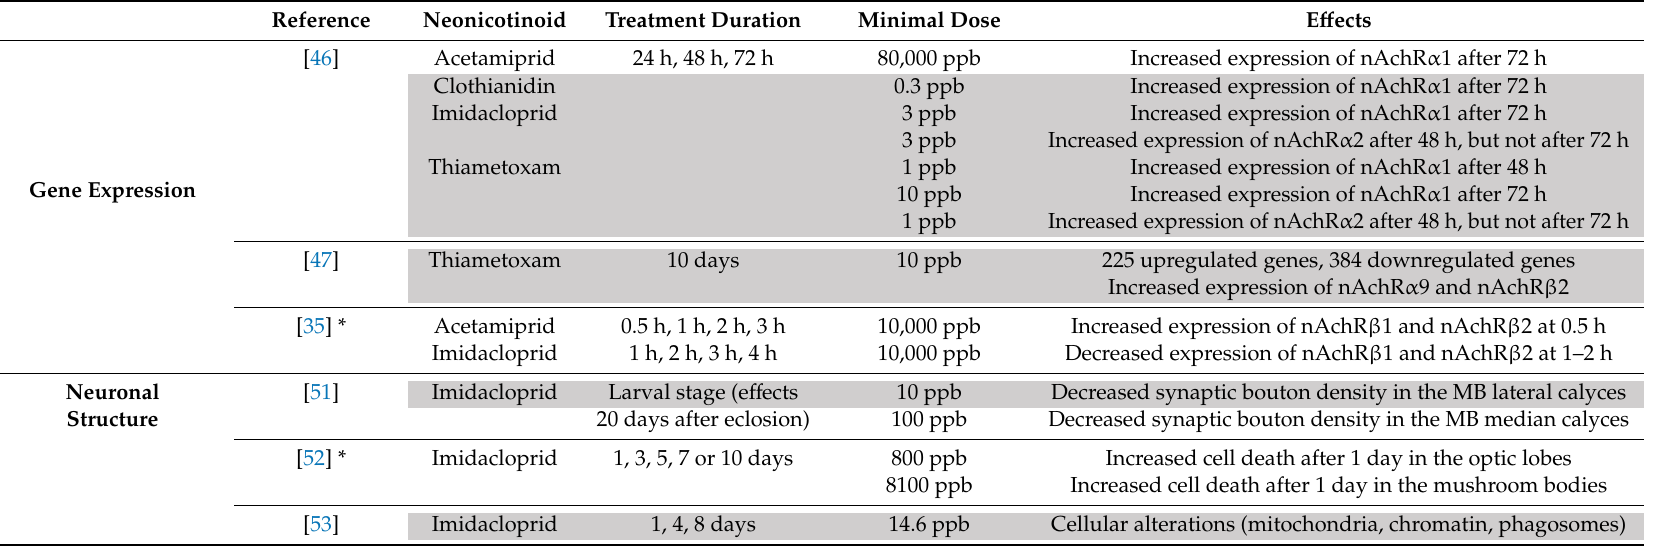
Table 1. Neuronal plasticity associated with chronic oral exposure to neonicotinoids in adult honeybees (* not European honeybees). Field-realistic doses based on [50] are highlighted in grey. nAchR: nicotinic acetylcholine